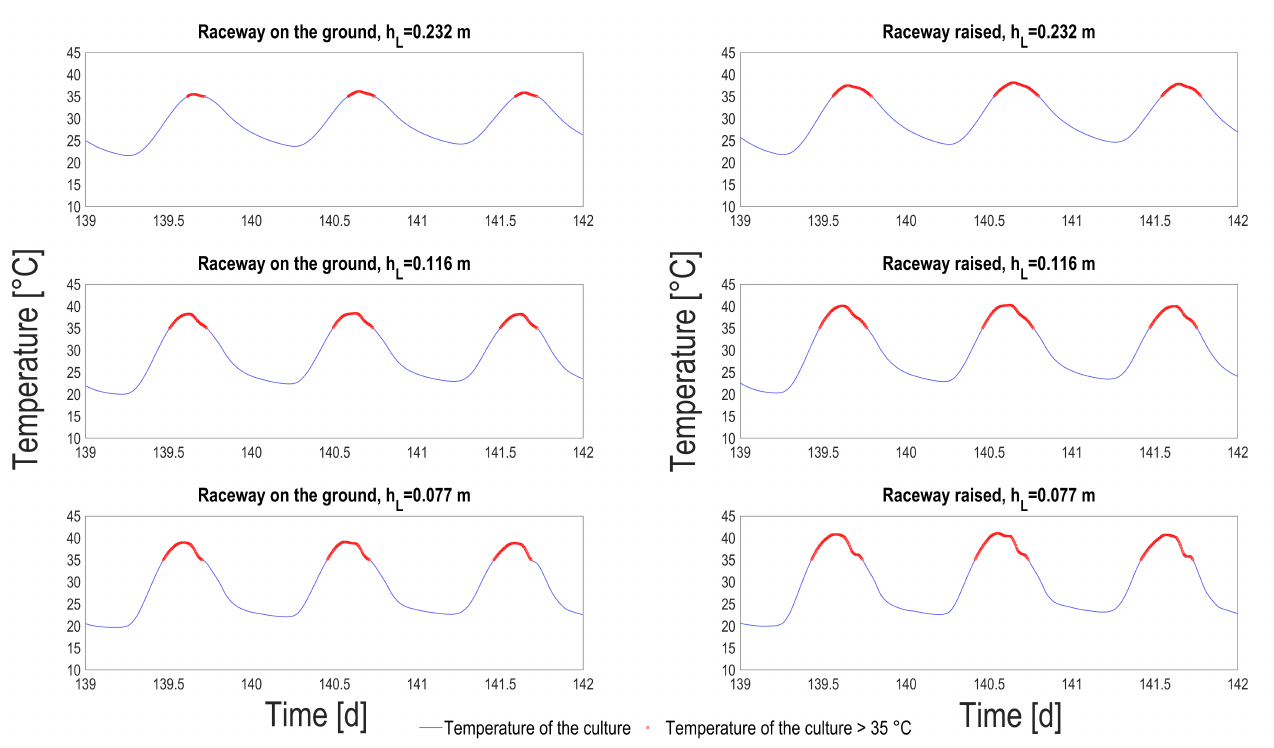
Figure 9. Pond temperature predictions (blue line) and simulated temperature higher than 35 ◦ C (red dots), according to the liquid depth tested ( h L ) and for both the raceway configurations: on the ground ( left column); raised ( right